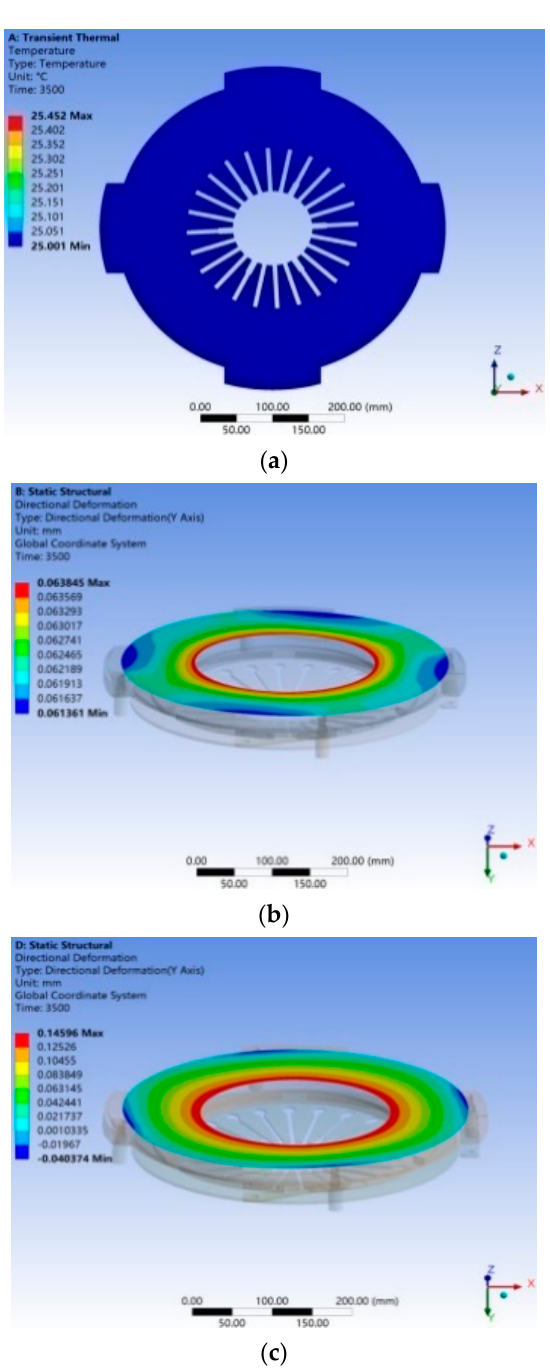
Figure 7. The temperature field ( a ), deformation field under constraint condition 1 ( b ), and deformation field under constraint condition 2 ( c ) of pressure plate at 3500 s.